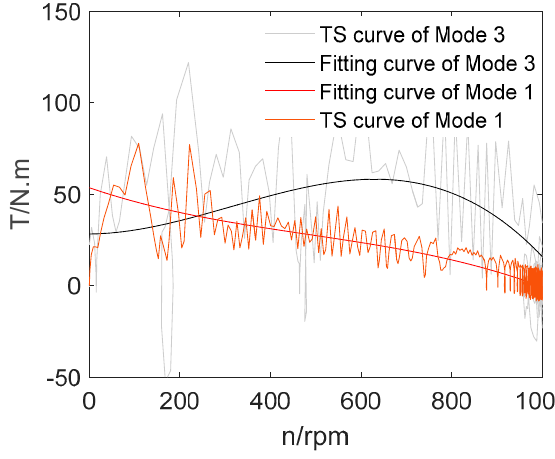
Figure 13. The fitting curve of transient torque-speed.